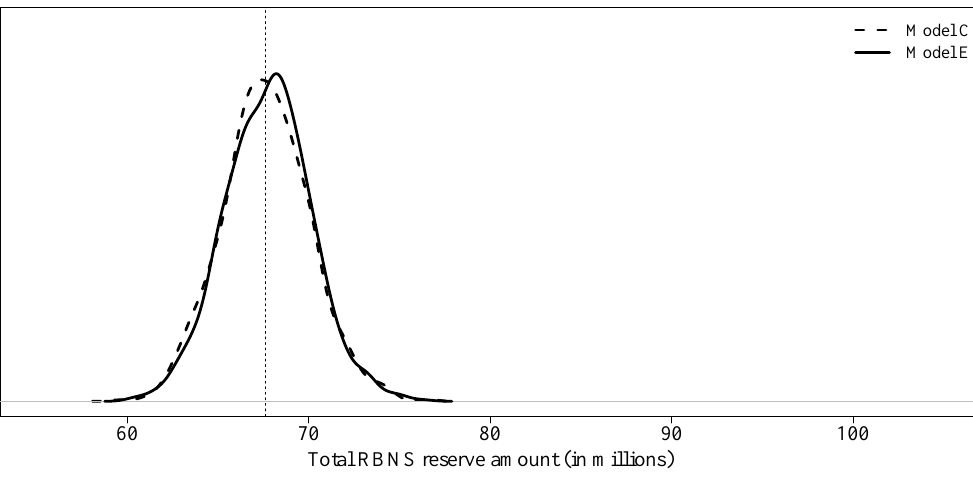
Figure 7. Comparison of predictive distributions for models E and